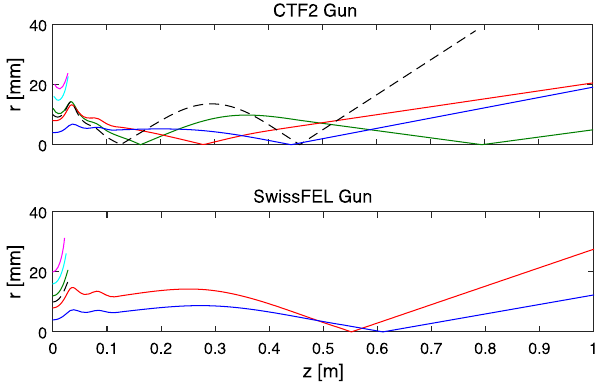
FIG. 9. Trajectories of particles emitted at distance r ¼ 4 , 8, 10, 12, 16, 20 mm from the center of the cathode. Each line corresponds to a different distance. The emission is at the time corresponding to the maximum field of the gun. The dashed line corresponds to a starting position of r ¼ 10 mm, where the gap of the cathode plug lies. The top plot refers to the CTF2 and the bottom one to the PSI gun,